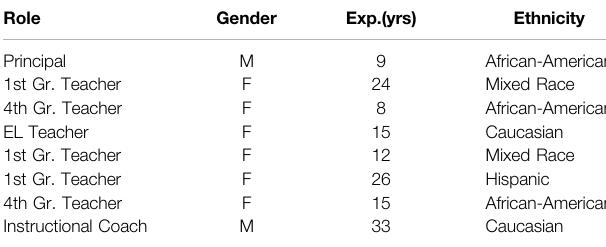
TABLE 3 | Demographics of school educators sample (n (cid:1) 8).